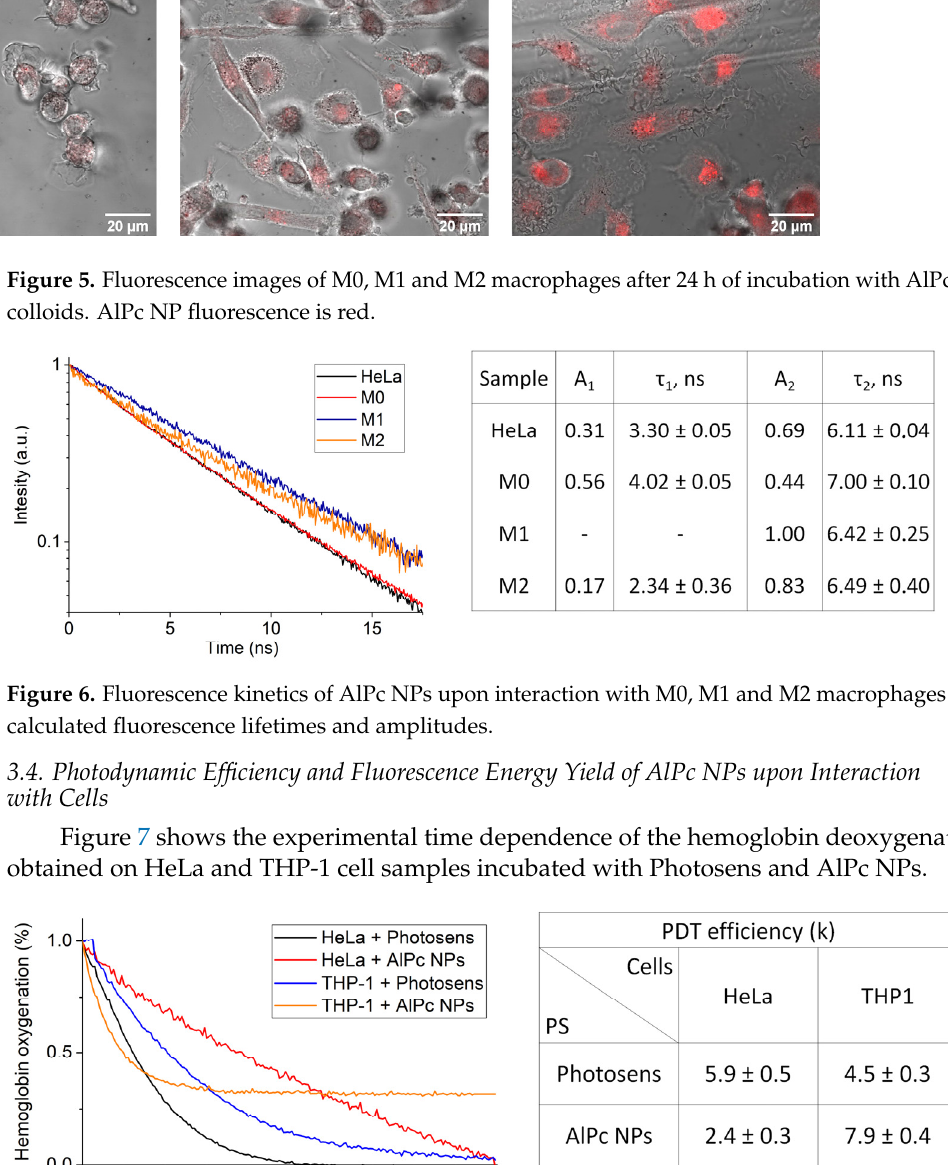
Figure 6. Fluorescence kinetics of AlPc NPs upon interaction with M0, M1 and M2 macrophages and calculated fluorescence lifetimes and amplitudes.